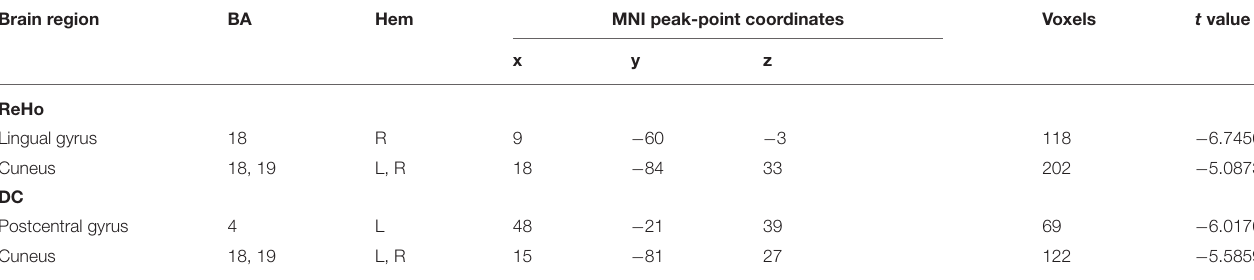
TABLE 3 | ReHo and DC alterations after rTMS treatment in the experimental group. Brain region